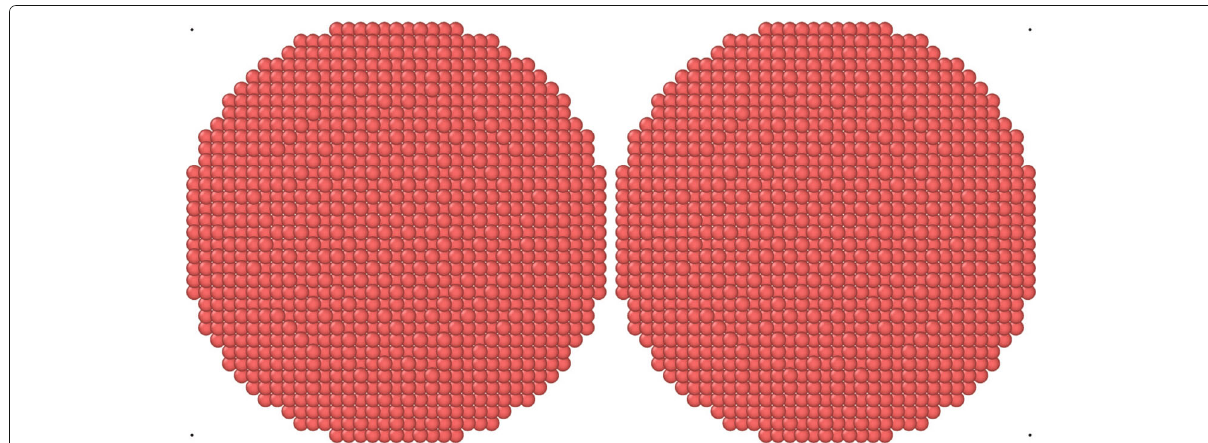
Fig. 2 Initial setup of the collision